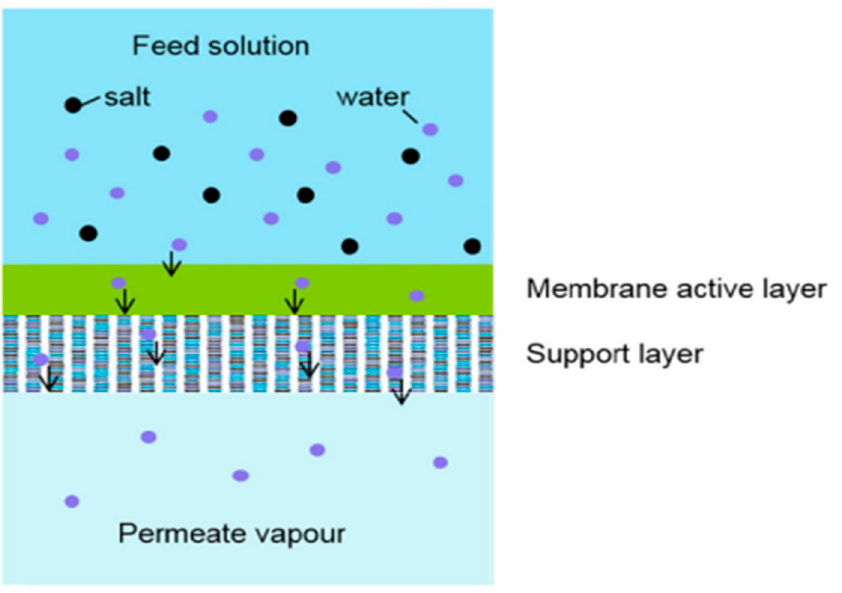
Figure 10. Desalination using